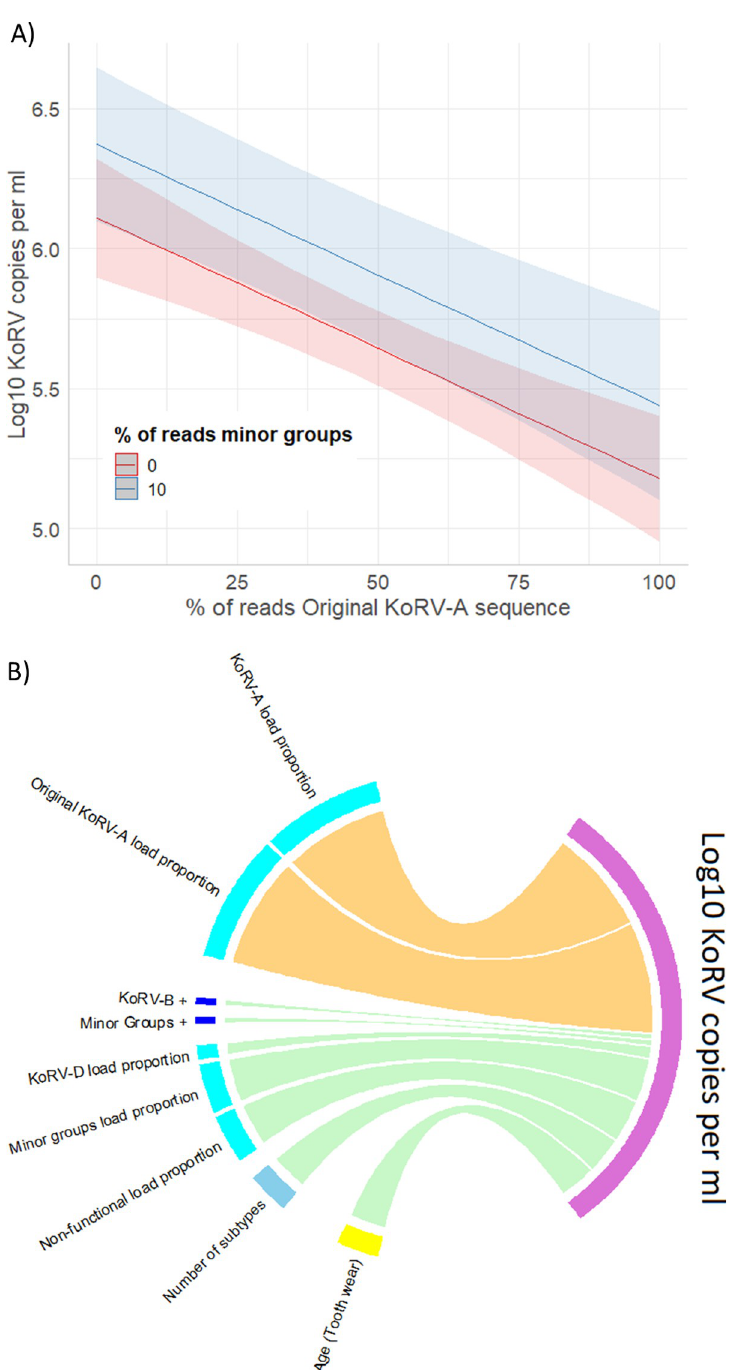
Fig 2. A) The best model of log10 KoRV pol copies per ml of plasma, which included the percentage of reads within a koala that were the original endogenous KoRV-A sequence and the percentage attributed to the minor groups as predictors. Predicted values from linear regression model are shown with 95% confidence intervals. B) Summary of significant sole predictors of log10 KoRV pol copies per ml of plasma as determined by univariate linear regression modelling. Positive relationships are shown in green, while negative relationships are orange. The width of the link reflects the strength (R 2 ) of the relationship: Age = 0.06 ( Δ AIC = NA, p = 0.036); Number of subtypes = 0.06 ( Δ AIC = 21.85, p = 0.003); Non-functional load proportion = 0.07 ( Δ AIC = 19.57, p < 0.001); Minor groups load proportion = 0.07 ( Δ AIC = 21.74, p = 0.003); KoRV-D load proportion = 0.02 ( Δ AIC = 26.27, p = 0.039), Minor groups + ( Δ AIC = 24.54, p = 0.015); KoRV-B + ( Δ AIC = 24.62, p = 0.015); Original KoRV-A load proportion = 0.18 ( Δ AIC = 0, p < 0.001); KoRV-A load proportion = 0.17 ( Δ AIC = 2.29, p < 0.001).